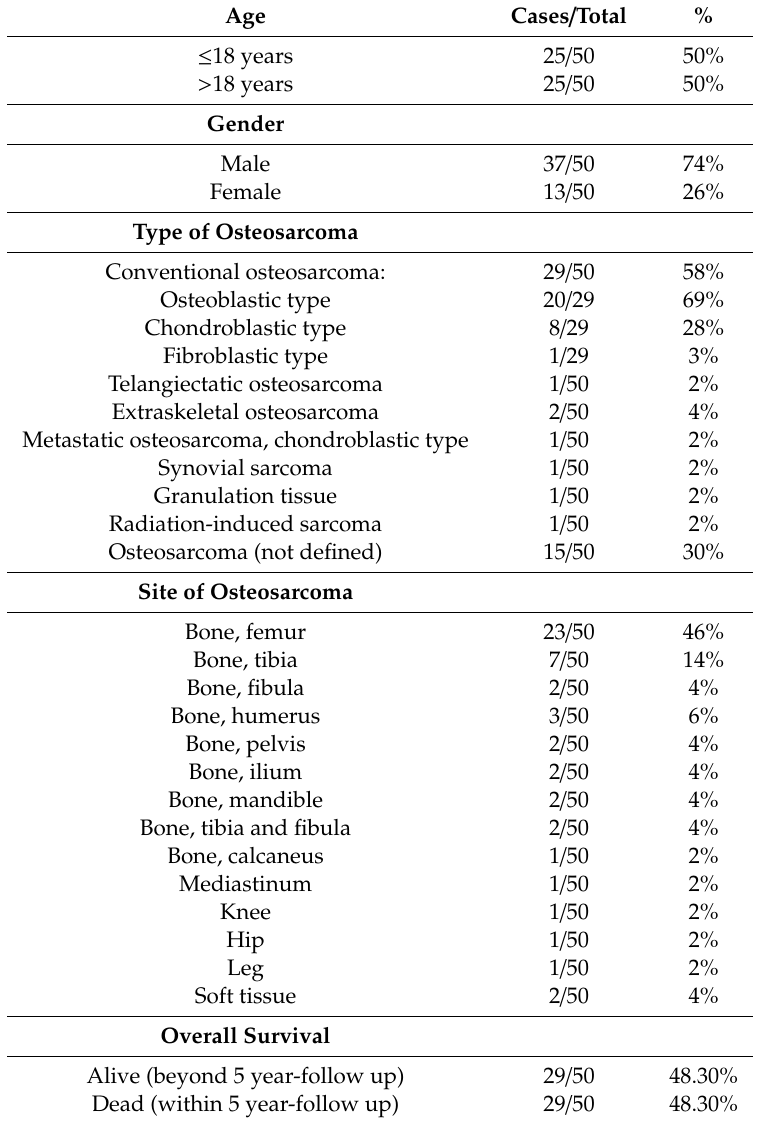
Table 1. The clinical-pathological data of the osteosarcoma patients on tissue microarray (TMA). Age Cases /